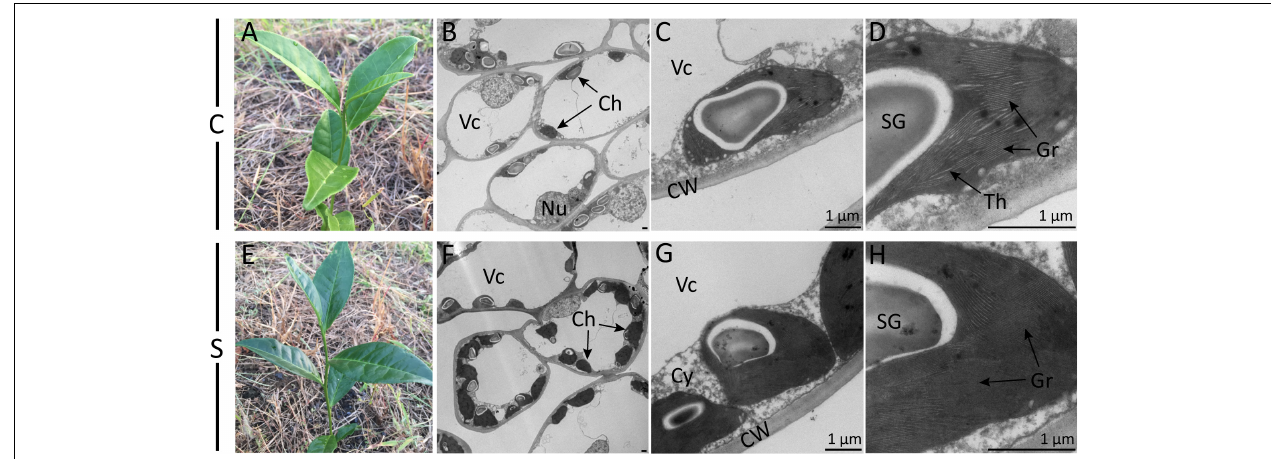
FIGURE 1 | Effect of shade on camellia leaves at the gross- and ultrastructural levels. Gross images show the coloration of typical control (A) and shaded (E) tea shoots. Photomicrographs show the ultrastructure of chloroplasts in both the control treatment (B–D) and the shade treatment (F–H) collected at 21 days of treatment. Magnifications of the TEM images were captured at × 0.7K (B,F) , × 5K (C,G) and × 12K (D,H) on a HT-7700 transmission electron microscope (Hitachi, Japan). Lead stain. C, control treatment; S, shade treatment; Vc, vacuole; Ch, chloroplast; Nu, nucleus; CW, cell wall; Cy, cytosol; SG, starch granule; Th, thylakoid; Gr, grana. Bars = 1 µ